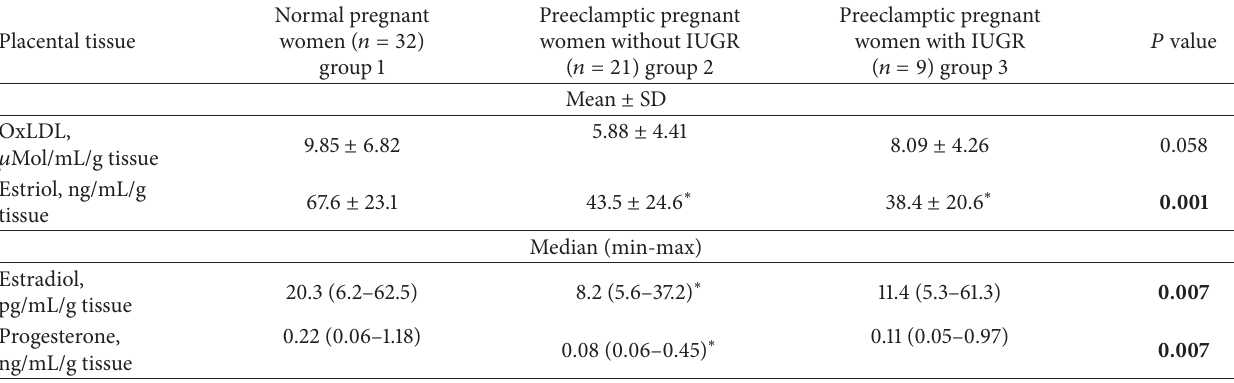
Table 5: Levels of OxLDL, estriol, estradiol, and progesterone in the placenta of preeclamptic without/with and normal pregnant women. Placental tissue